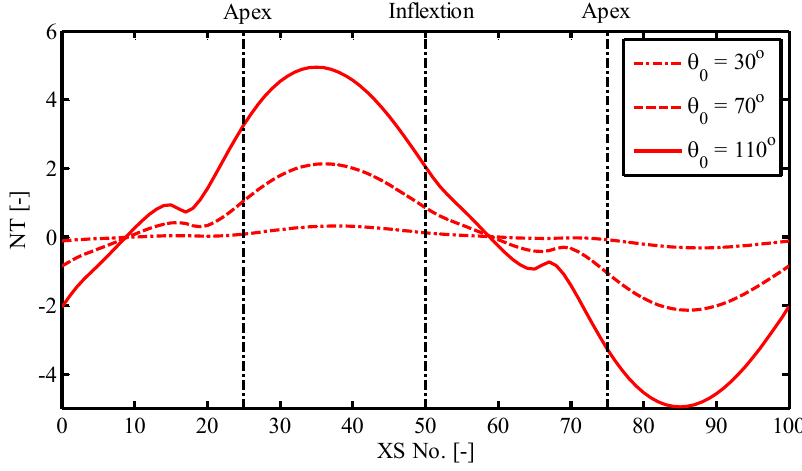
Figure 5. Sensitivity analysis of NT magnitude on the maximum direction angle θ 0 . NT = the difference between the magnitudes of the RHS terms of Equations (16) and (17); XS No. = cross-section number in the model. The channel starts and ends at the inflexion.